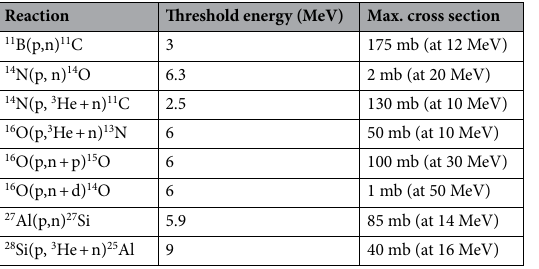
Table 3. Summary of the main proton reaction channels leading to neutron production with threshold energies and maximum cross sections, ordered according to the atomic number of the target element.